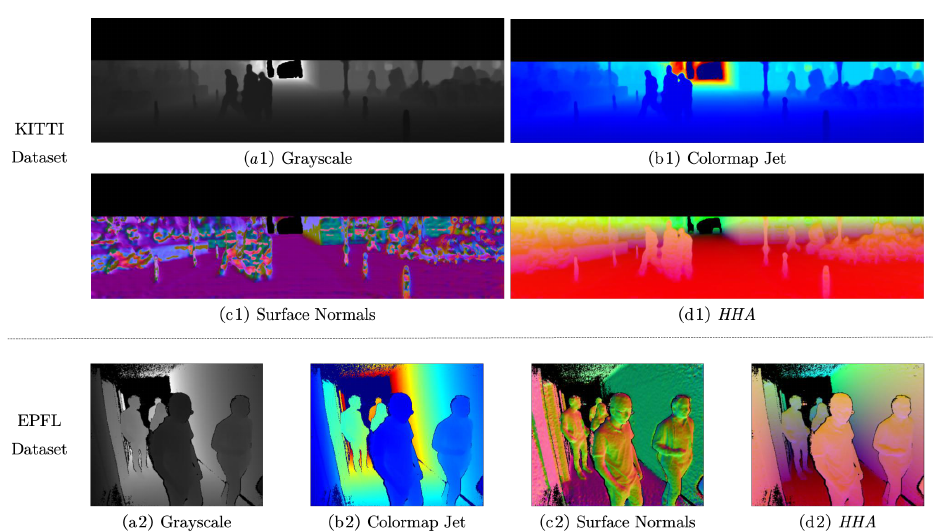
Figure 2. Sample images after encoding the depth information via different methods on the two